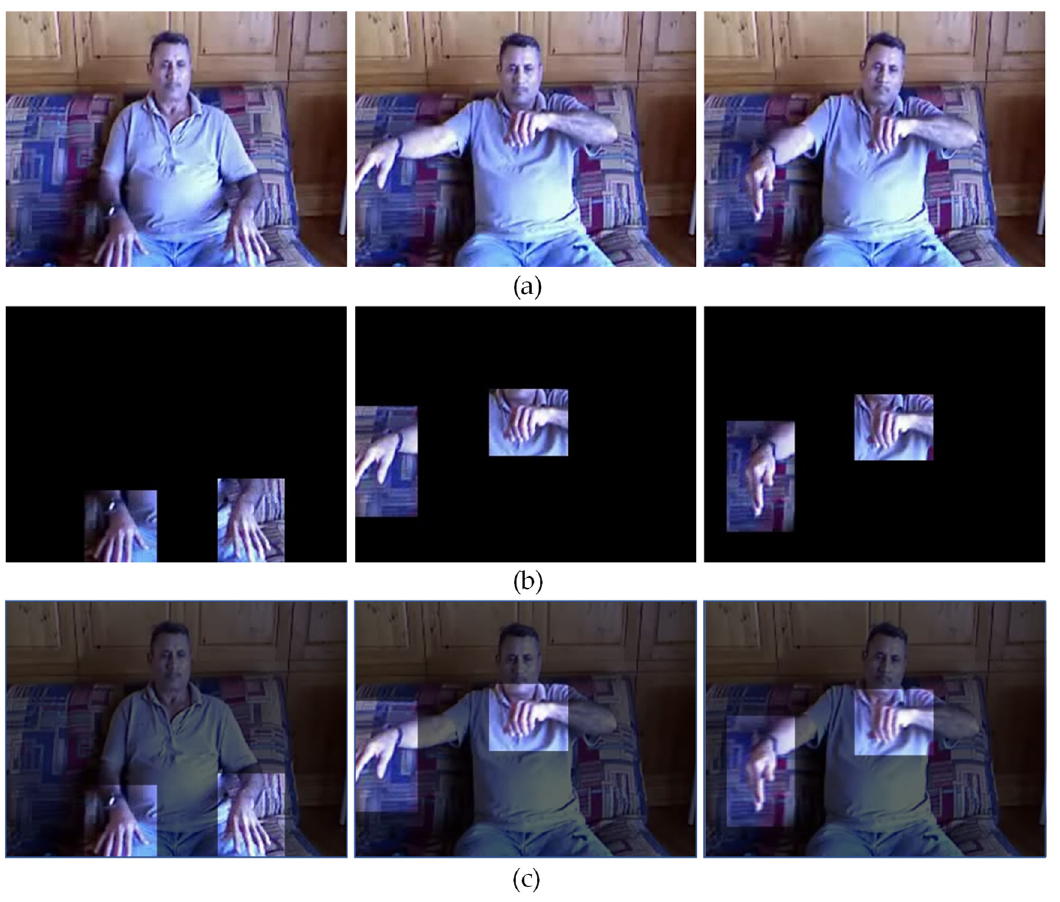
Figure 2. Sample of different data used in local attention: ( a ) raw RGB data; ( b ) hand data processed by hand detector; ( c ) fusion of raw RGB data and hand data.